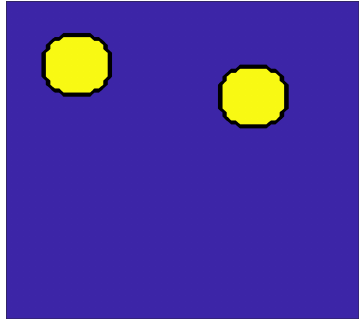
Figure 2. The initial state u with 0 ≤ u ≤